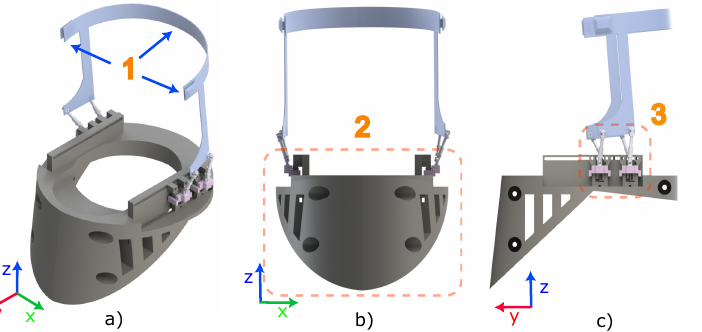
Figure 1. Orthosis design in a CAD software. ( a ) Isometric view; ( b ) frontal view; and ( c ) lateral view.